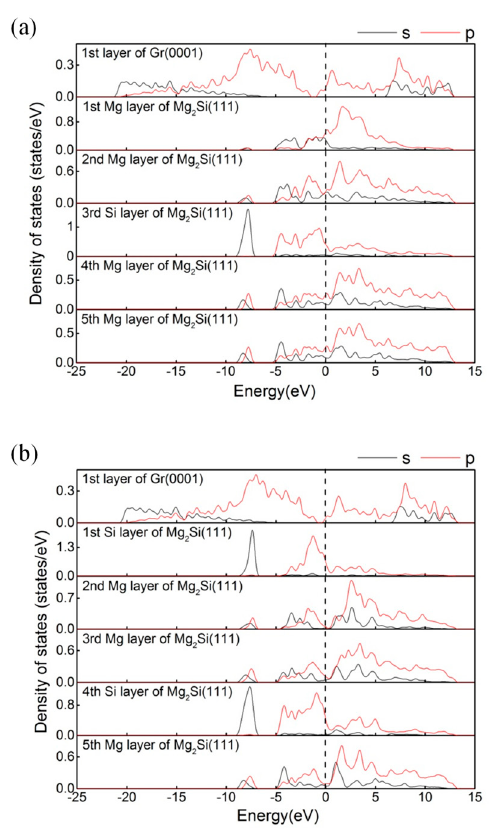
Figure 11. Partial density of states for Mg 2 Si (111)/Gr (0001) interfaces: ( a ) Mg-termination; ( b ) Si-termination.